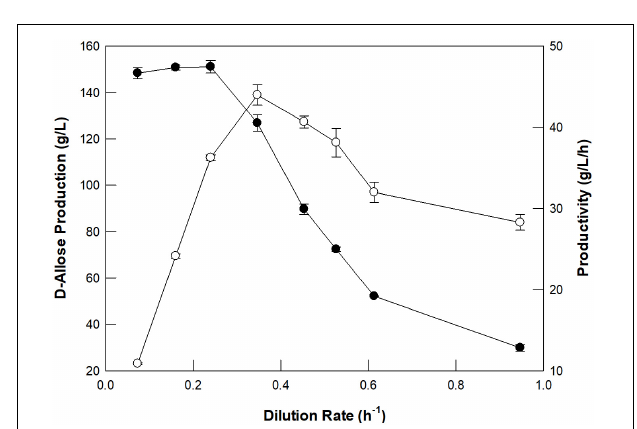
FIGURE 4 | Effect of the dilution rate of D -allulose on D -allose production (closed circles) and productivity (open circles) using a packed bed reactor. The working volume of the reactor was 300 mL. A solution of 50 mM EPPS buffer (pH 8.0) containing 500 g/L D -allulose in the feeding reservoir was fed continuously into the reactor, and the effluent was allowed to flow out of the reactor to a reservoir using a peristaltic pump. The temperature was maintained at 70 ◦ C using a water circulator. Data represent the means of three experiments ±